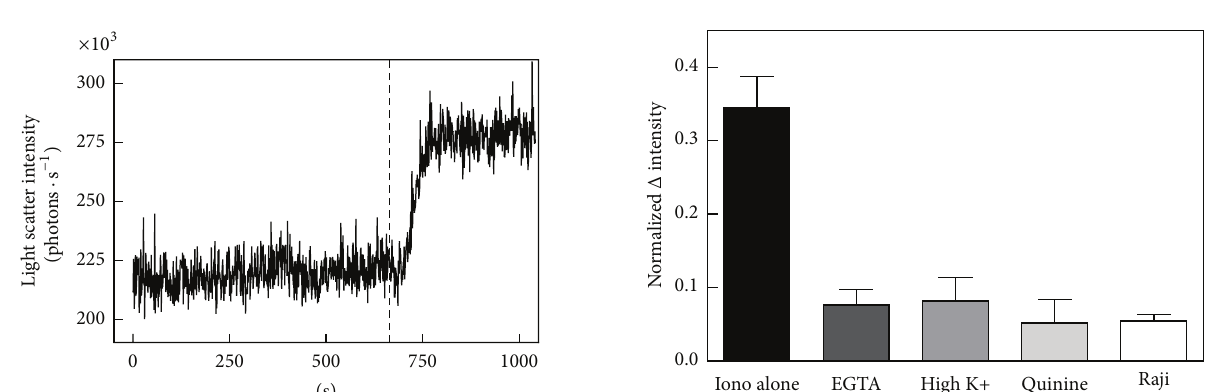
Figure 1: Confocal photographs of actin cytoskeletal without (a) or with (b) ionomycin treatment at 37 ∘ C. The actin cytoskeleton of S49 cells was stained with phalloidin.